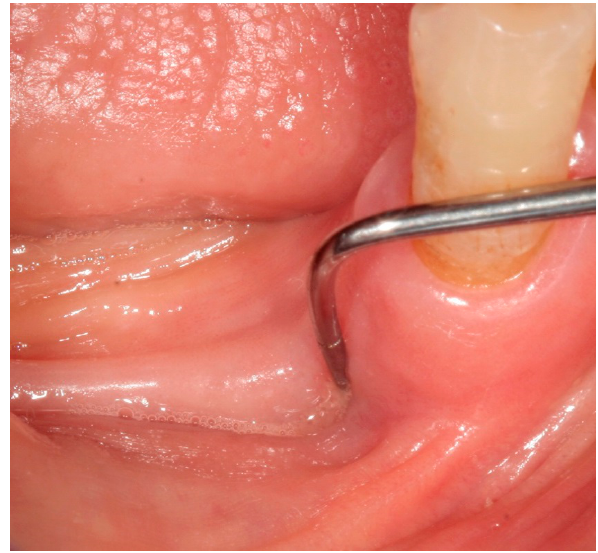
Figure 5. Fistula that probes to bone distal to 43.